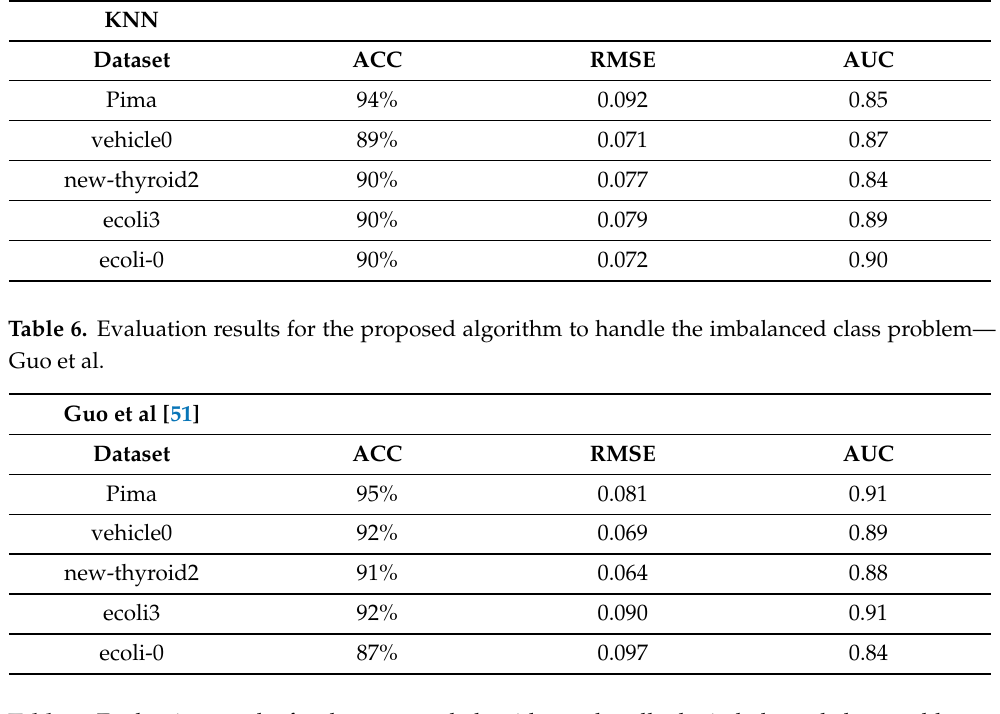
Table 7. Evaluation results for the proposed algorithm to handle the imbalanced class problem— proposed